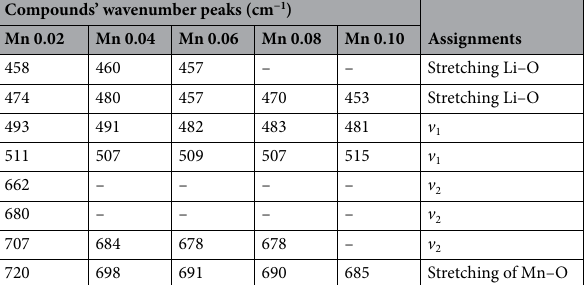
Compounds’ wavenumber peaks (cm −1 ) AssignmentsMn